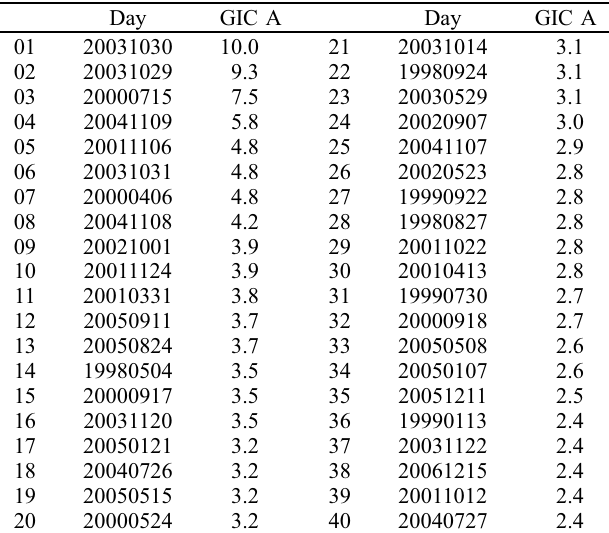
Table 4. Most active GIC days in the European high-voltage power grid according to the maximum 1-min sum of GIC of all nodes divided by the number of nodes.